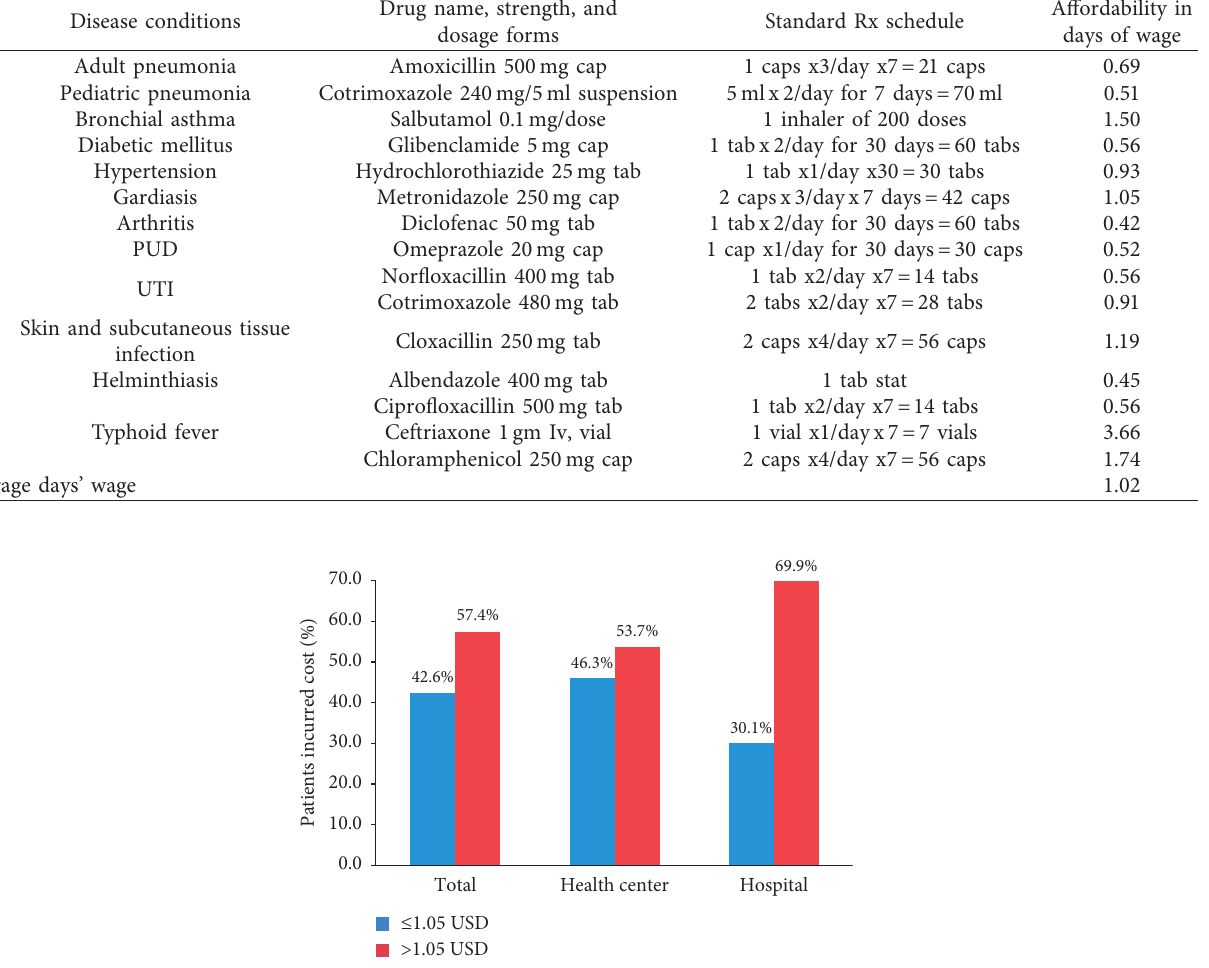
Figure 1: Percentage of patients who incurred costs on medicines in relation to the daily wage of an LPGW (1.05